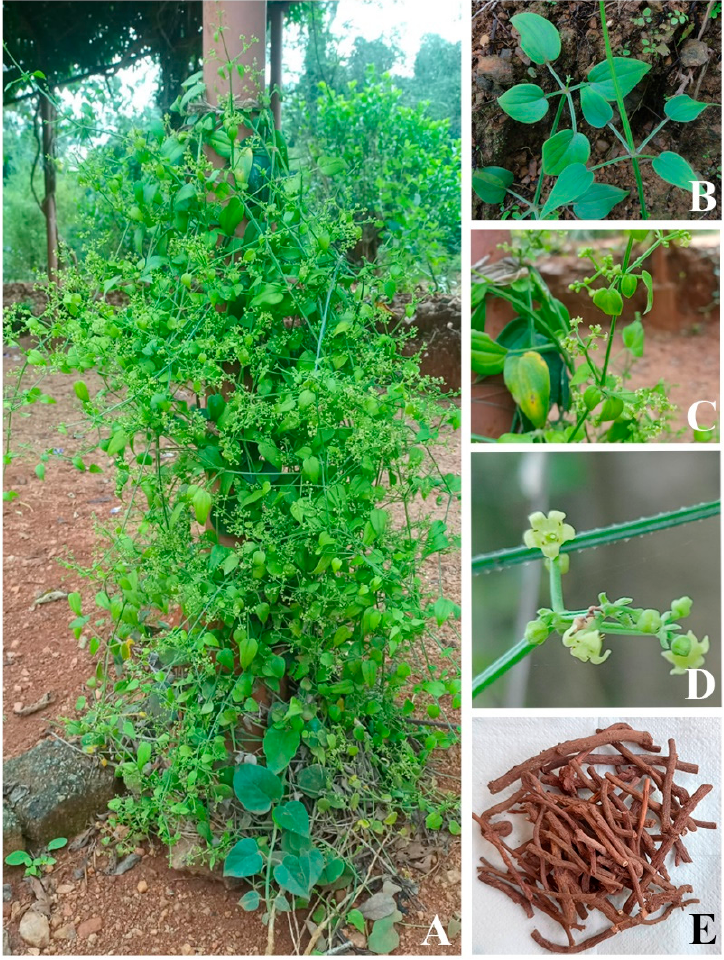
Figure 1. Rubia cordifolia plant ( A ), leaves ( B ), flowering twigs ( C , D ), dried roots ( E ) (photos were taken by the authors).